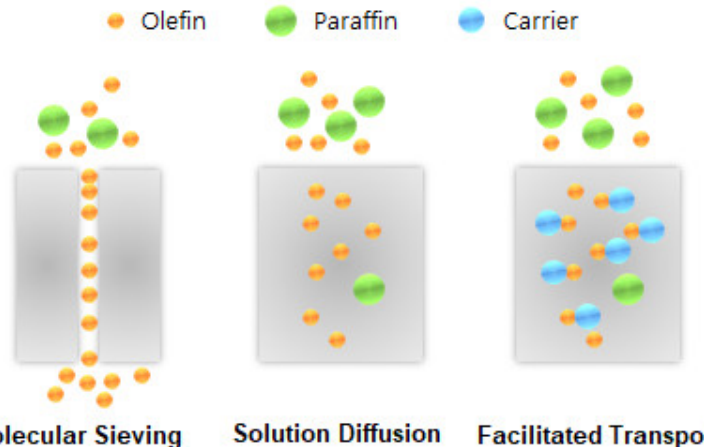
Figure 2. Molecular sieving, solution diffusion, and facilitated transport mechanisms.